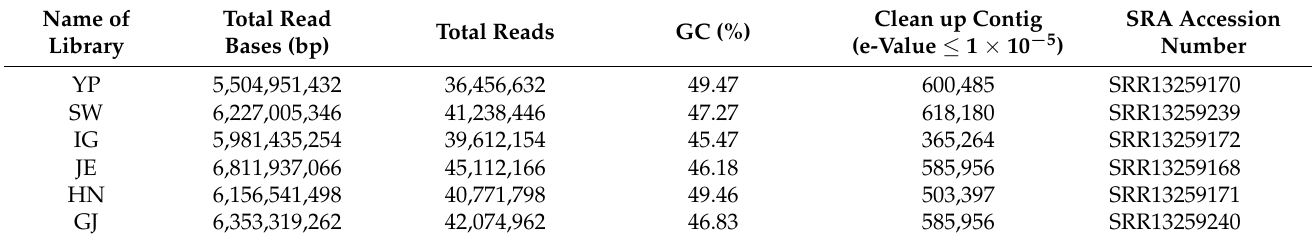
Table 2. Summary of paired-end sequencing results for oat viromes using HiSeq4000 system.